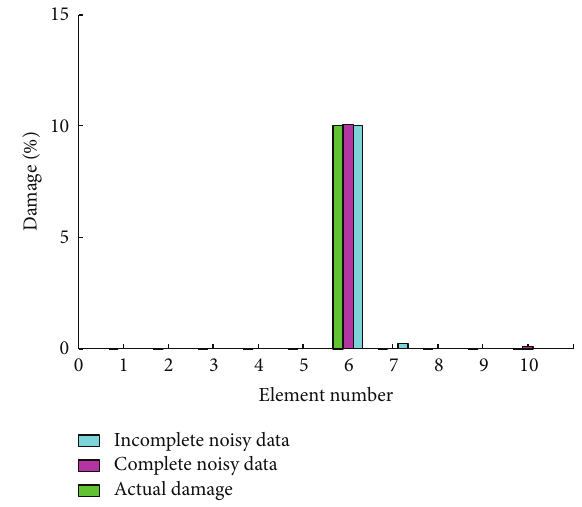
Figure 5: Damage distribution of cantilever beam using the com- plete and incomplete noisy data in Scenario 2.